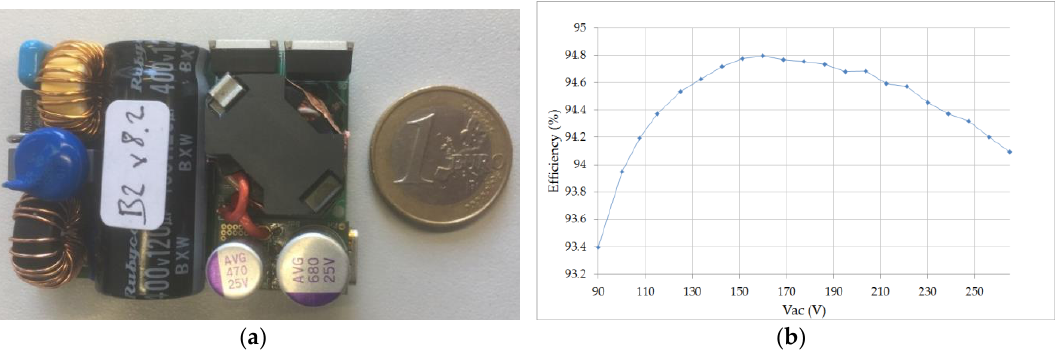
Figure 9. ( a ) Asymmetric flyback converter prototype; ( b ) full load efficiency versus input voltage range.